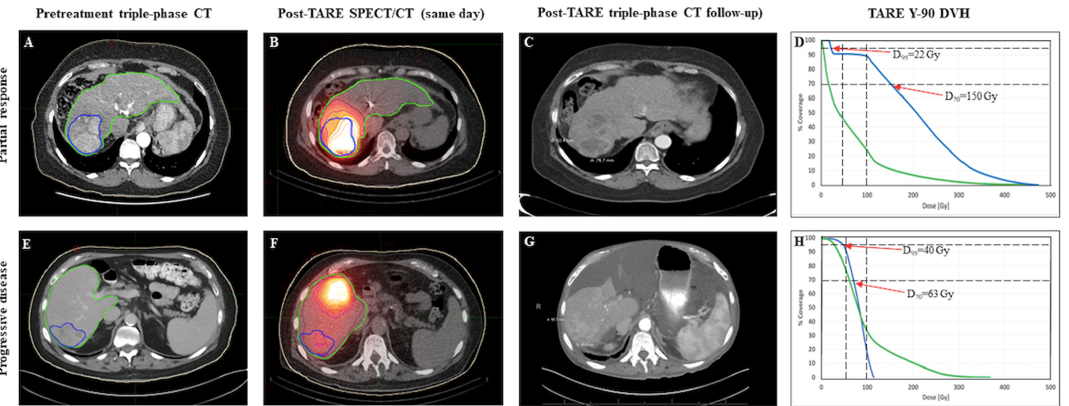
Figure 2. Cases of partial response (PR; top row ) and progressive disease (PD; bottom row ). Gross tumor volume is delineated in blue and liver volume in green on pretreatment diagnostic imaging (Panel A,E) and post-Y90 same day SPECT (Panel B,F). Follow up imaging shows areas of necrosis (Panel ( A , E )) and post-Y90 same day SPECT (Panel ( B , F )). Follow up imaging shows areas of necrosis within the treated volume for the responder (Panel C), and new tumor growth in the non-responder within the treated volume for the responder (Panel ( C )), and new tumor growth in the non-responder (Panel G). (Panel ( G